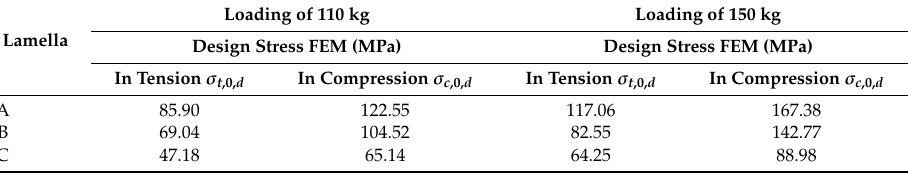
Table 4. Maximum values of normal stress for the pitch seat-to-back angle of 103°.